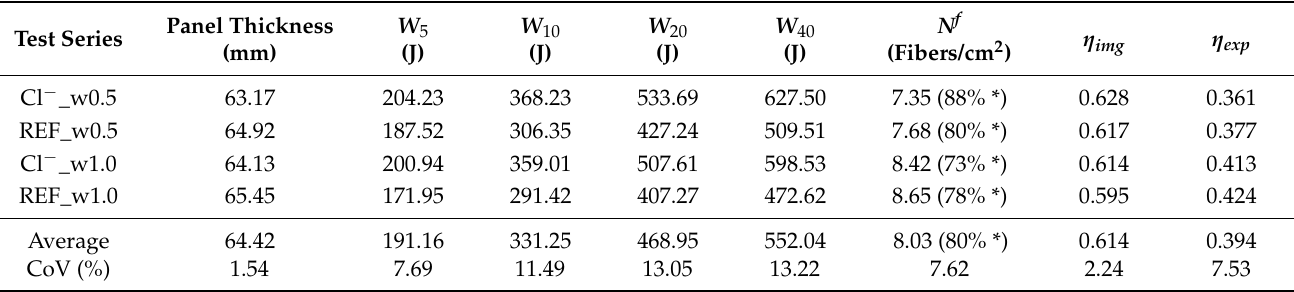
Table 6. Fiber distribution and orientation parameters for the analyzed crack surface after